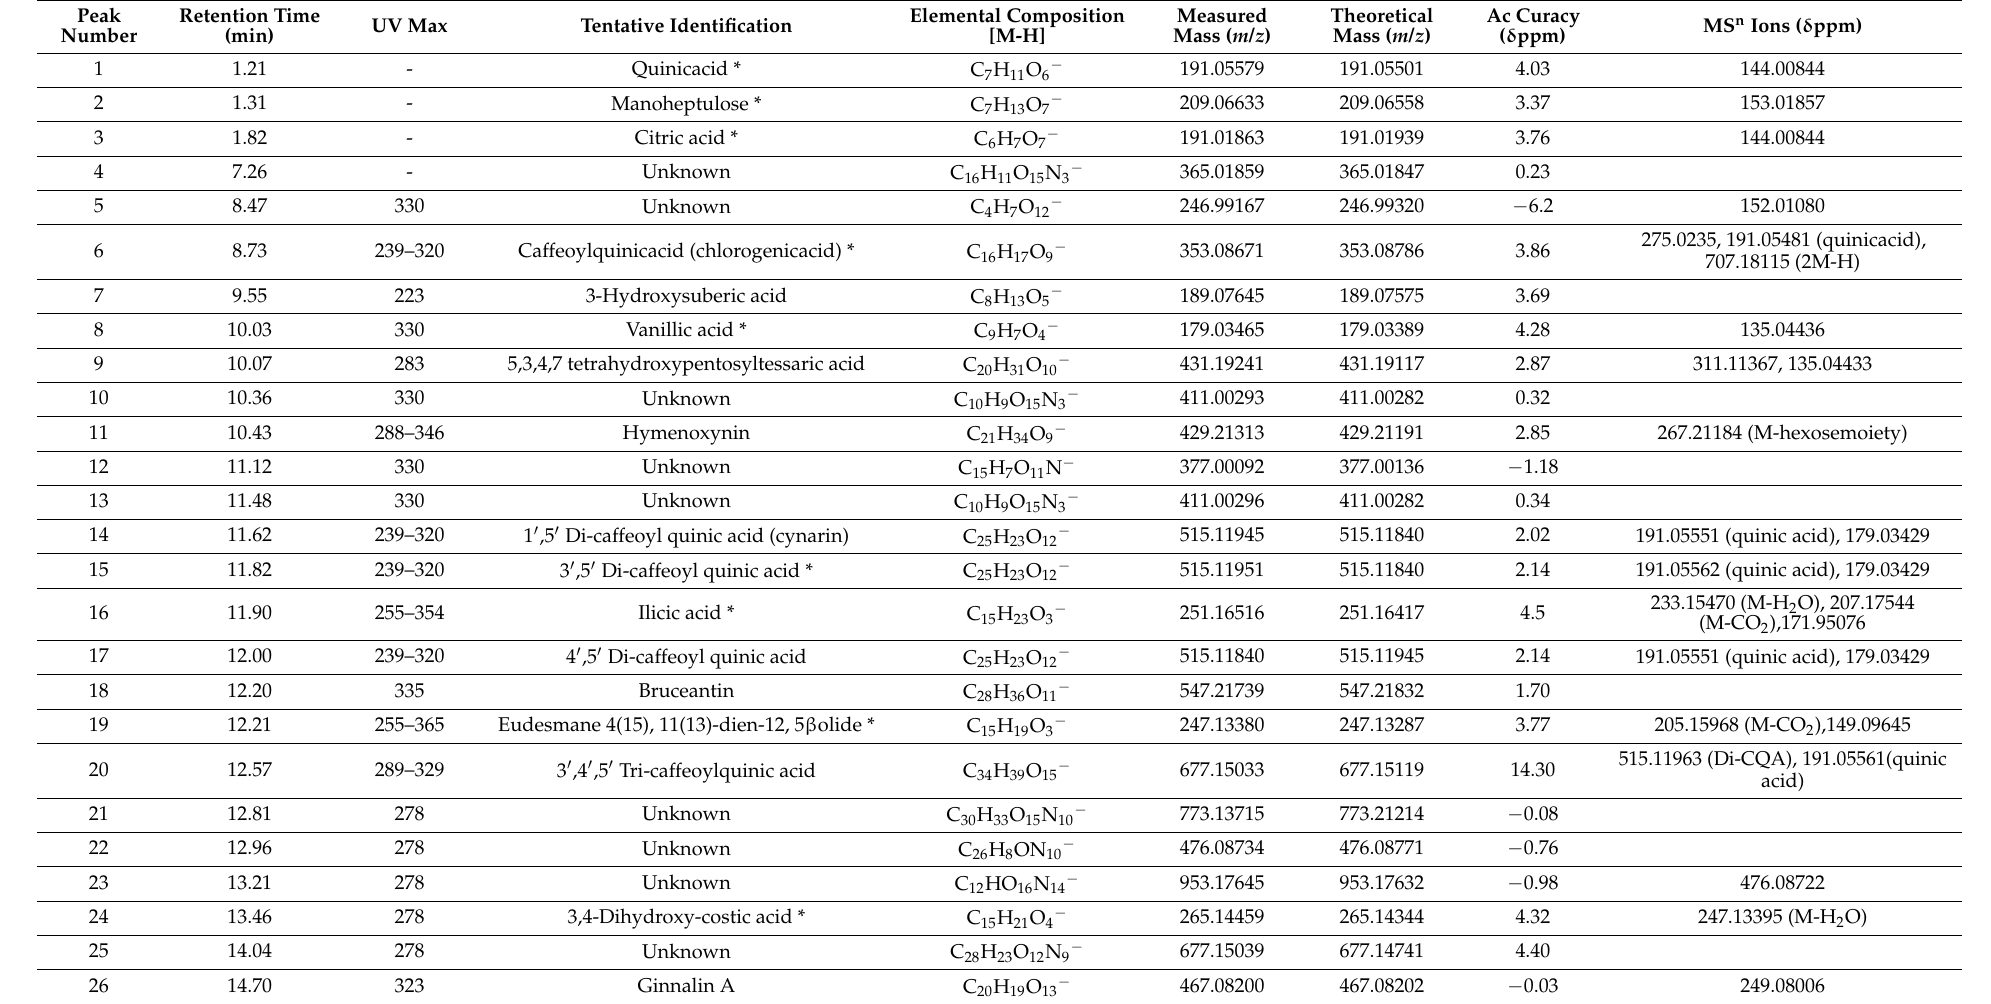
Table 2. High resolution UHPLC PDA-Q orbitrap identification of metabolites from